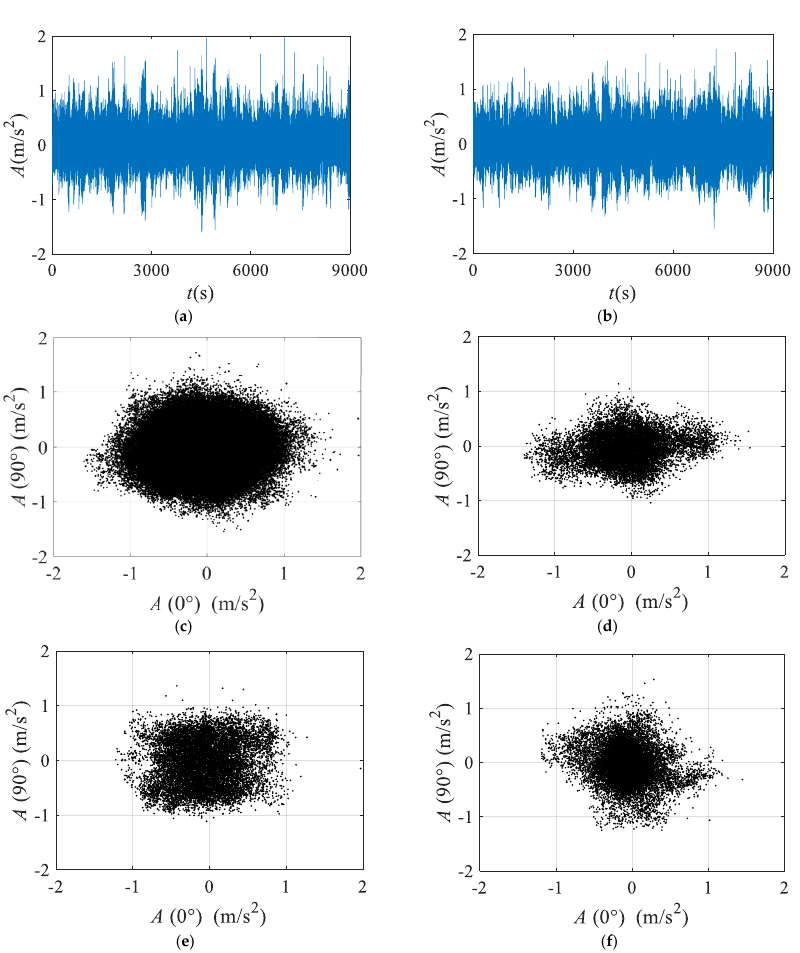
Figure 2. Ten minute accelerometric signal records at the building top with 𝑈 = 49.0 m/s, along wind (0°) ( a ) and across wind (90°) ( b ).